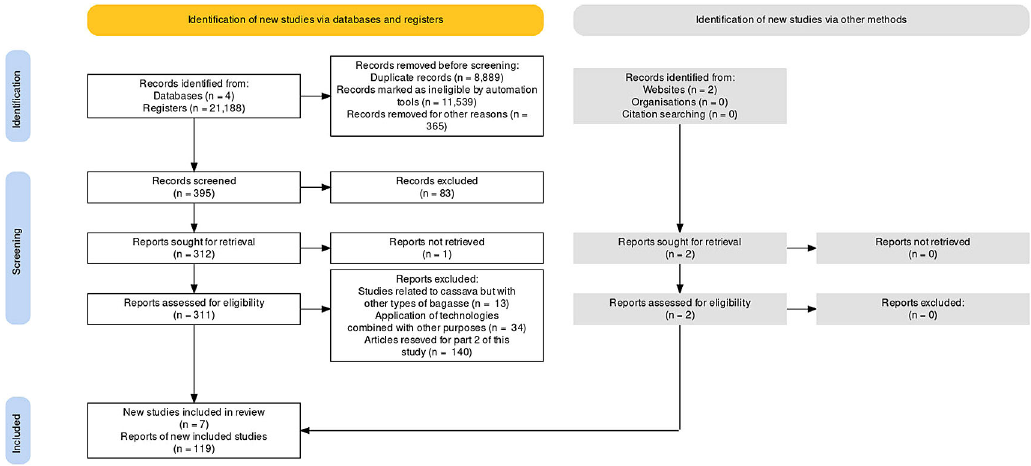
Figure 1. PRISMA flow diagram: selection of sources of